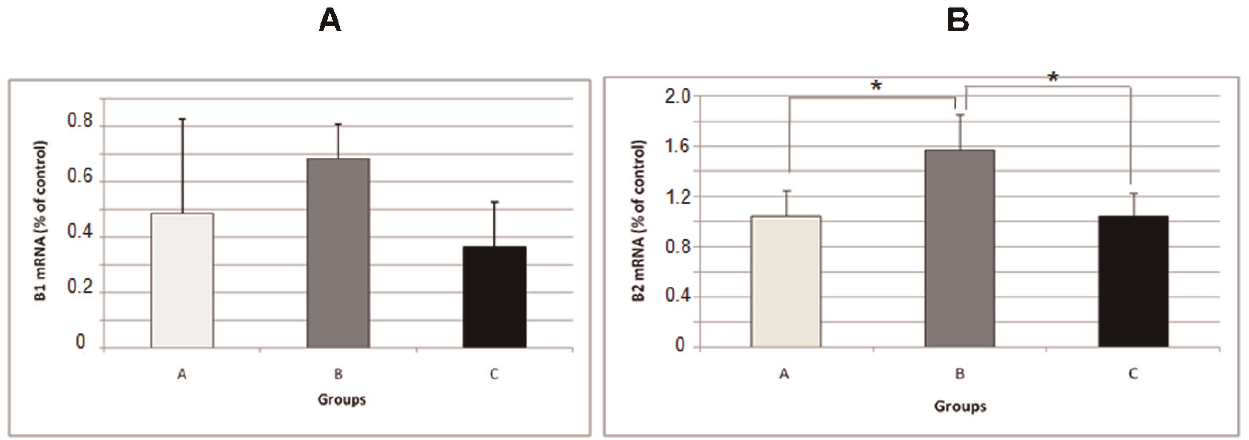
Figure 4 - mRNA expression levels of the kinin B1 receptor (A) and kinin B2 receptor (B) in the hippocampus of rats in the pilocarpine model of epilepsy as evaluated with a real-time PCR assay. All data have been normalized to the levels of GAPDH. The data are presented as the mean ¡ S.E.M. (n=5 per group).